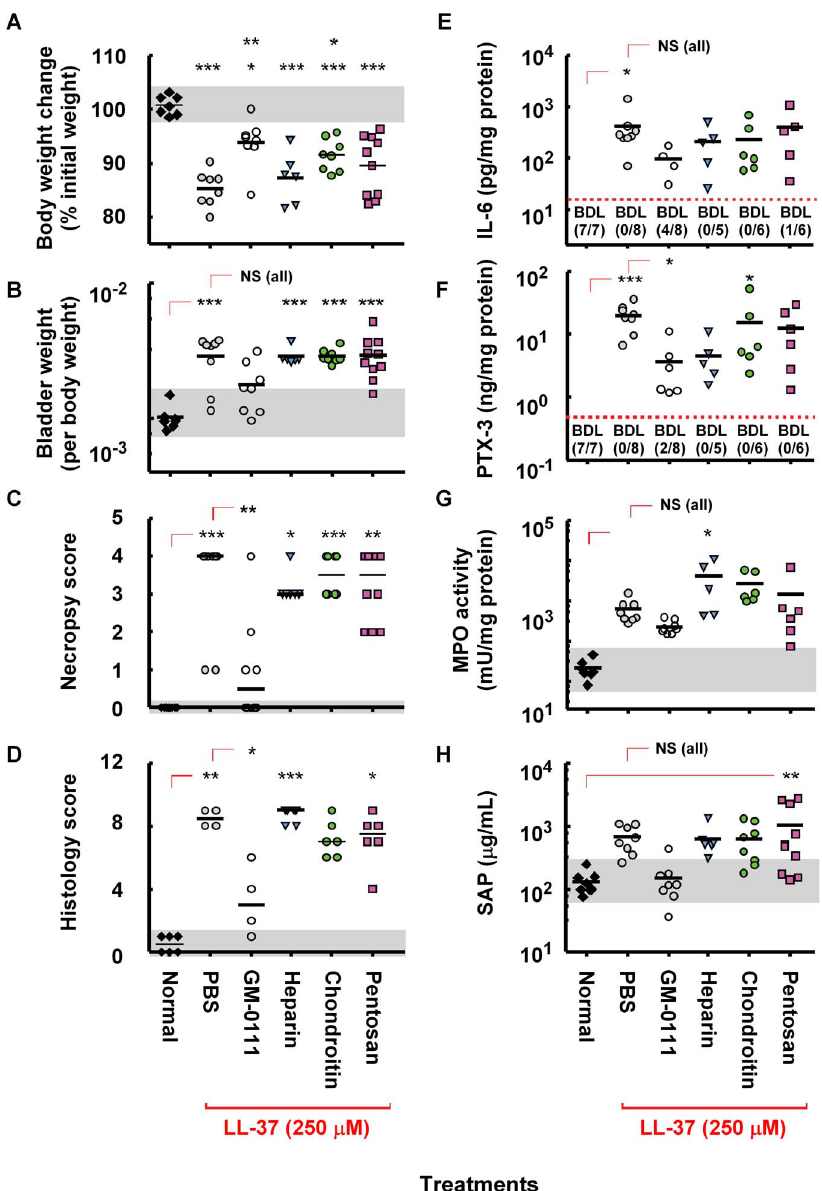
Figure 8. The protective effects of GM-0111 against LL-37 induced cystitis are more powerful than other GAG compounds. The animals receiving each compound at 10 mg/mL dosage by intravesical instillation prior to LL-37 instillation showed variable responses in clinical signs of IC and decreased molecular markers in the serum and tissues. Only the animals treated with GM-0111 were effectively protected from the LL-37 challenge. * p , 0.05, ** p , 0.01, and *** p , 0.001 compared to either normal or PBS/LL-37 instilled control group. NS, not significant ( p . 0.05) by Dunnet’s t -test. Black horizontal bars are mean or median (necropsy and histology scores) values. BDL and the values in the parenthesis represent the number of samples that fell below the detection limit (red dotted line) of the ELISA out of the total samples tested. For data analysis purposes, any values below the detection limit were listed as being at the detection limit, which may in some cases overestimate the numerical value. Gray area represents the range of values found in normal